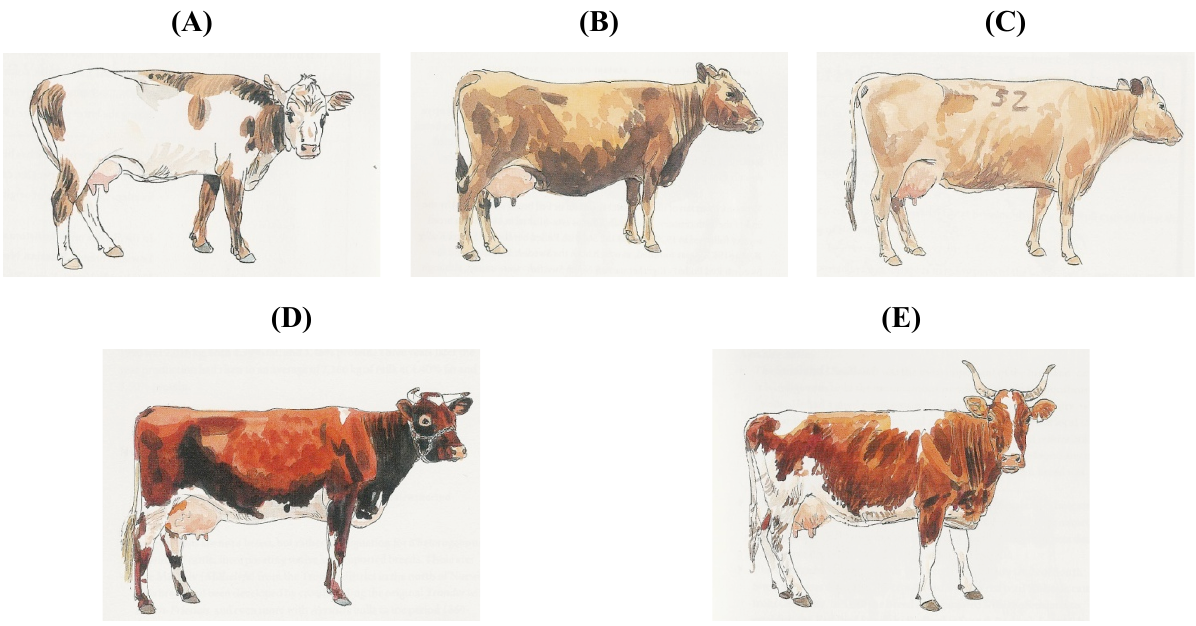
Figure 7. Different colors and patterns in Nordic-Baltic cattle. ( A ) Icelandic; ( B ) West Finncattle; ( C ) Estonian Native; ( D ) Norwegian Red and ( E ) Swedish